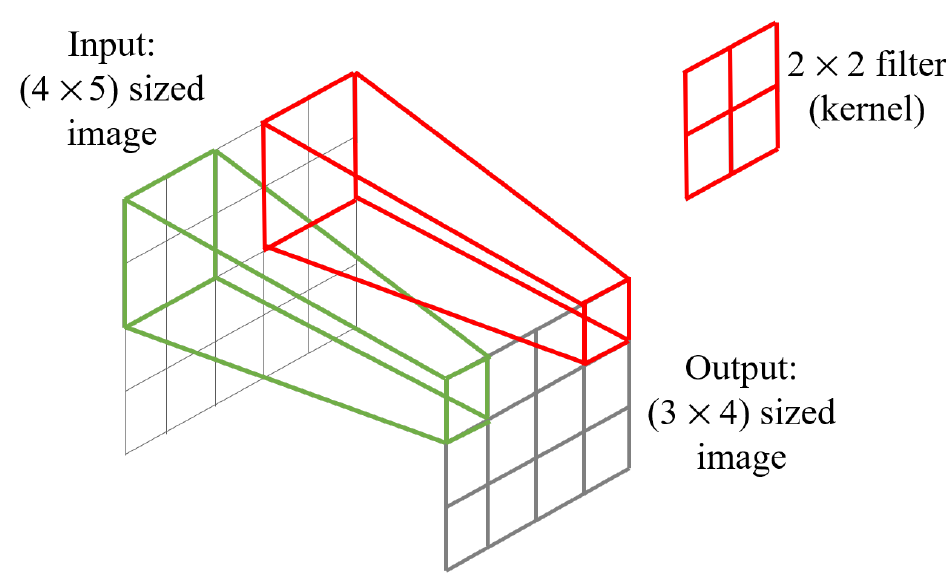
Figure 2. Convolutional operation using 2 × 2 kernel.